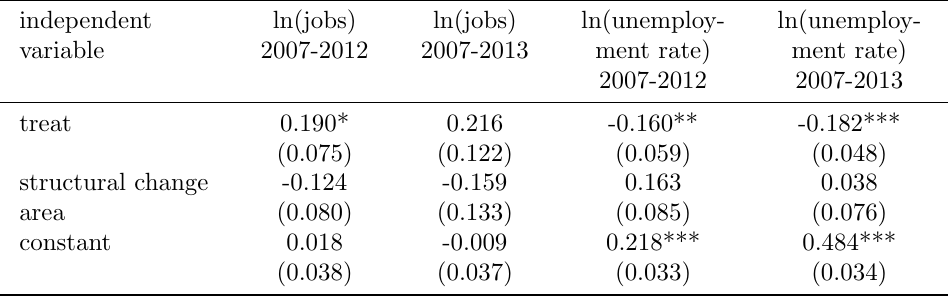
Table 5: Controlling for the areas of abrupt structural change, previous transitional areas